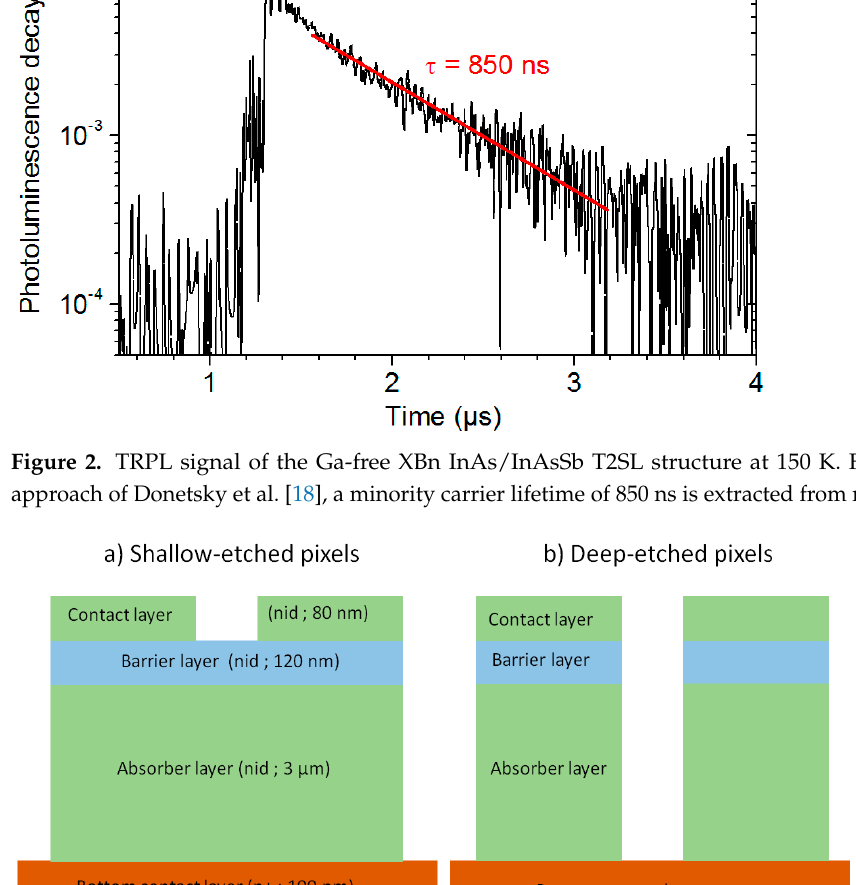
Figure 3. Schematic view of shallow-etched ( a ) and deep-etched ( b ) pixels.